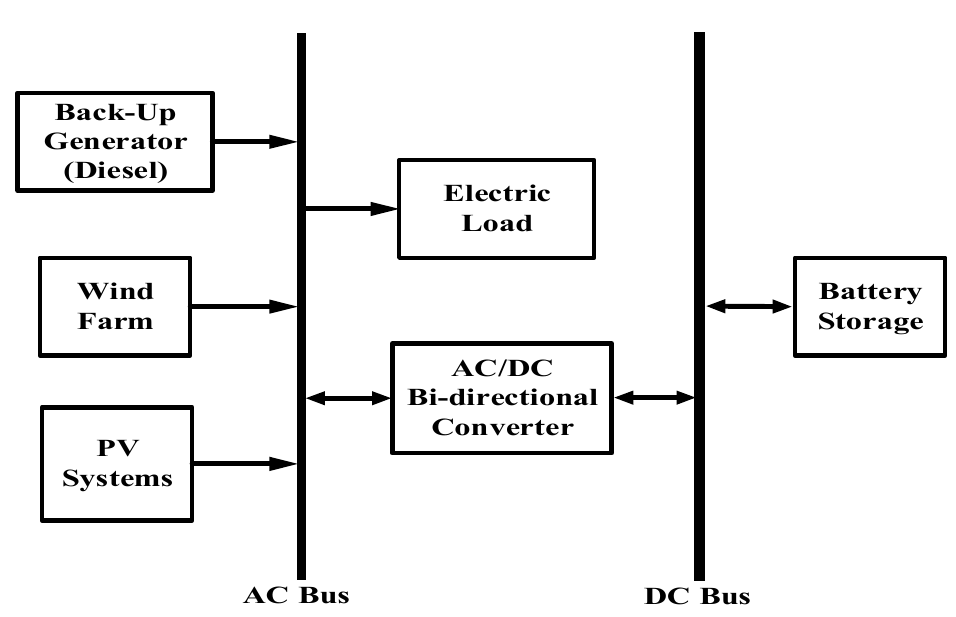
Figure 3. Schematic diagram of the Kangaroo Island hybrid microgrid optimization model.